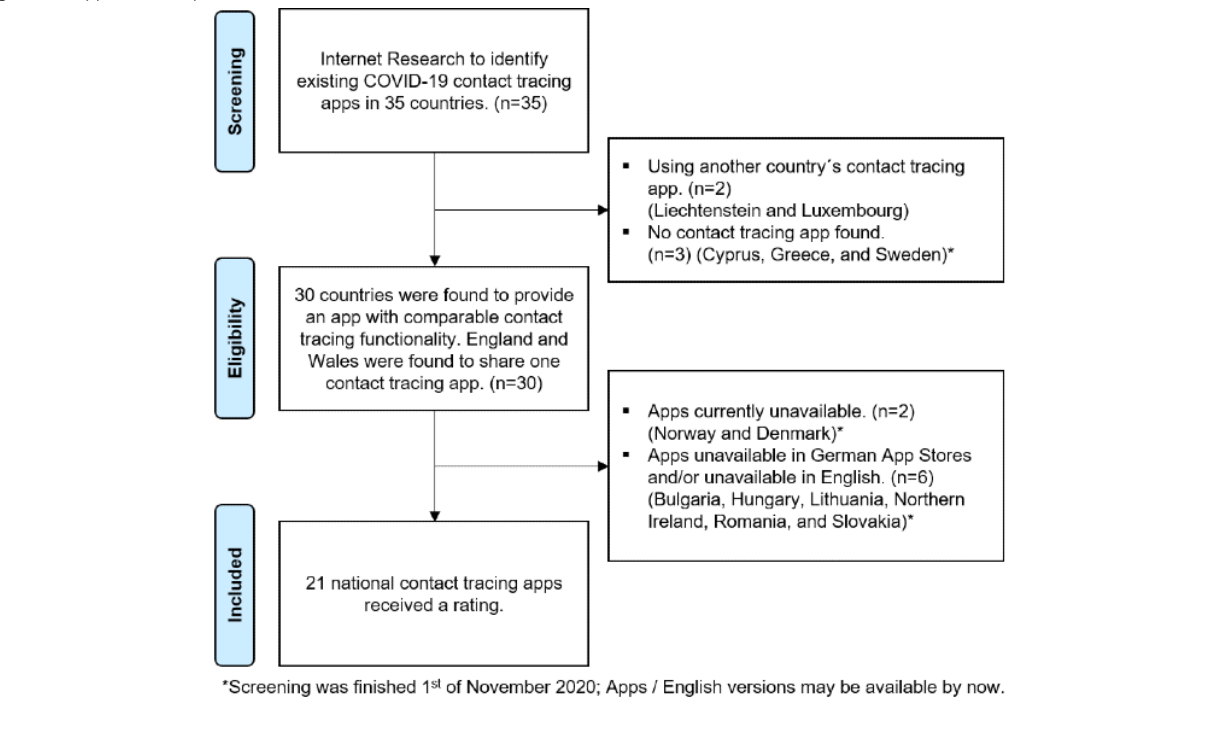
Figure 1. App selection process